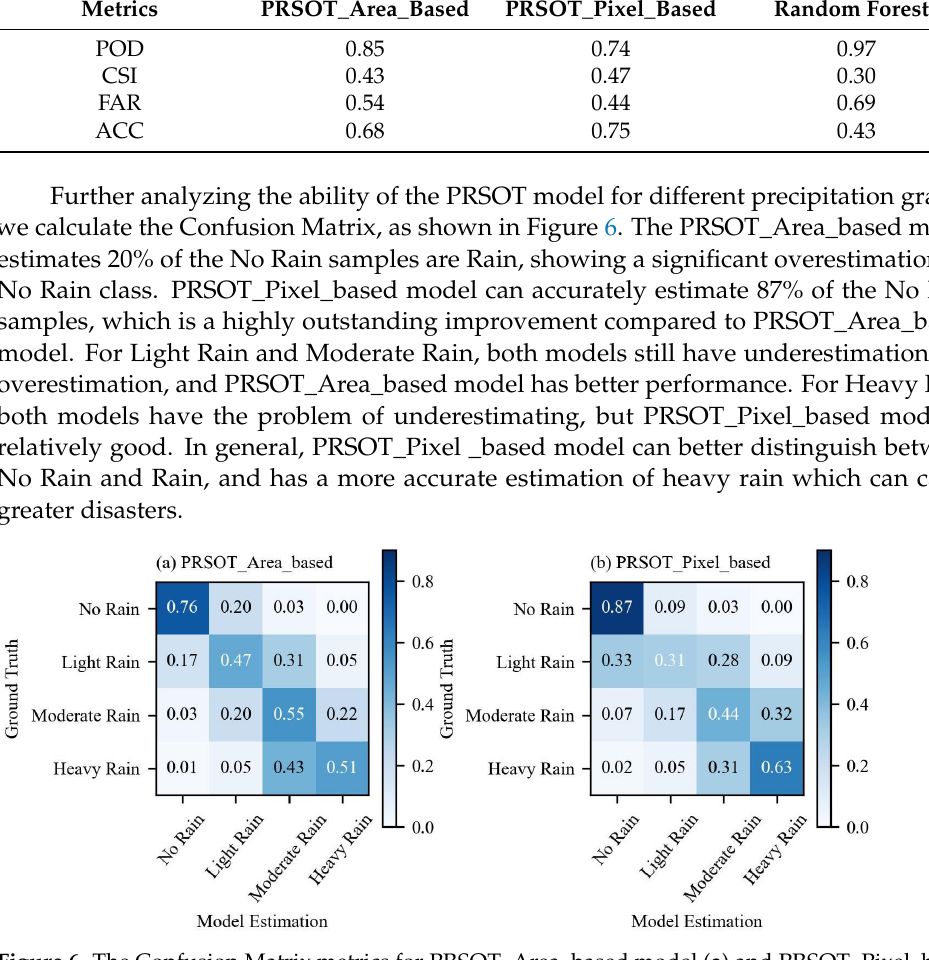
Figure 6. The Confusion Matrix metrics for PRSOT_Area_based model ( a ) and PRSOT_Pixel_based model ( b